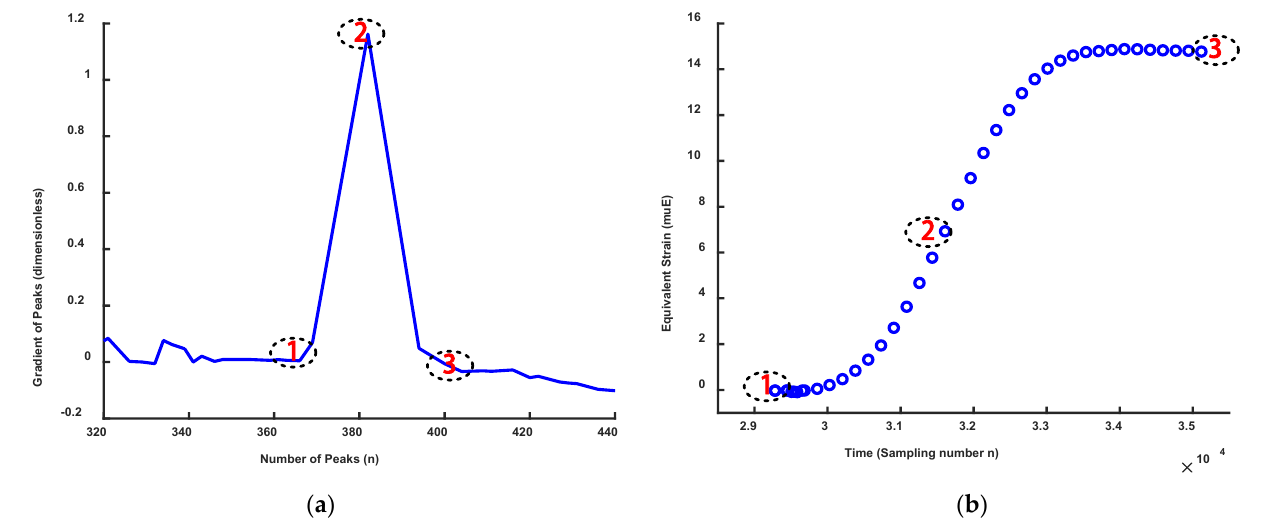
Figure 13. ( a ) The gradient of the peak value (amplitude of sine wave). ( b ) The value of the oscillation period. The point marked number 1 and 3 represented the point that the gradient equals to zero, the point marked number 2 represented the point that the gradient reached the maximum.